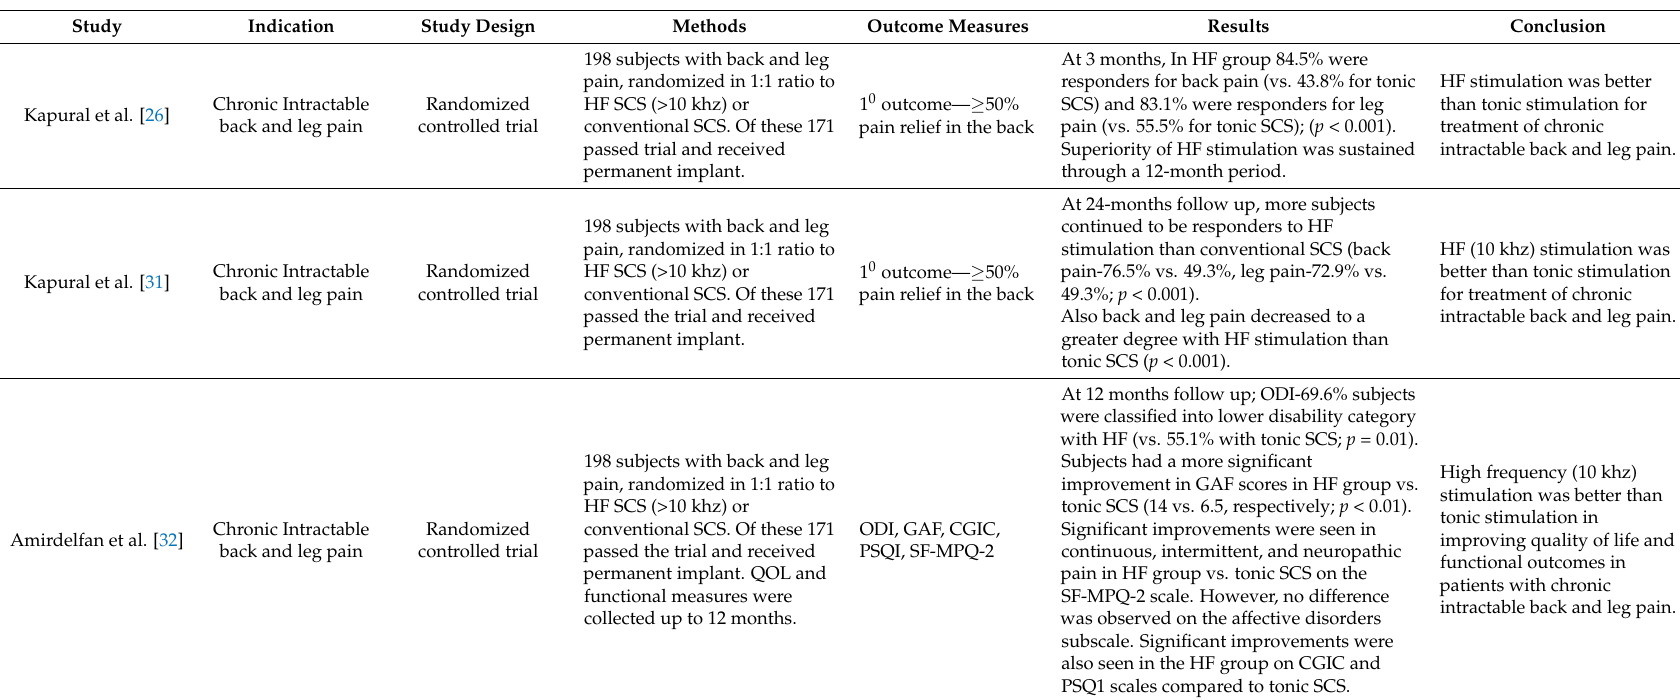
Table 2. Comparative studies between conventional/tonic & High Frequency (10 khz)